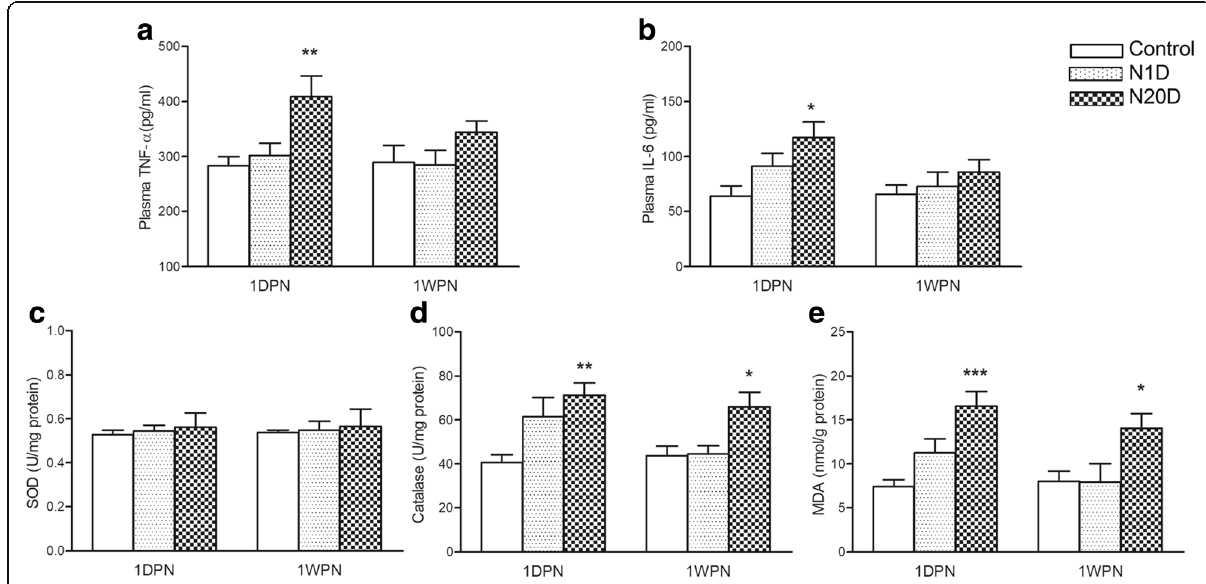
Fig. 4 Effect of noise exposure on biomarkers of inflammation and oxidative stress. a , b Plasma levels of TNF- α ( a ) and IL-6 ( b ). c – e Activity of SOD ( c ) and CAT ( d ) and the level of MDA ( e ) in the gastrocnemius muscle. Values are presented as the mean±SEM of 8 mice per group. * p <0.05, ** p <0.01, and *** p <0.001 indicate significantly different mean values in post hoc comparisons between N20D and the control after a one-way